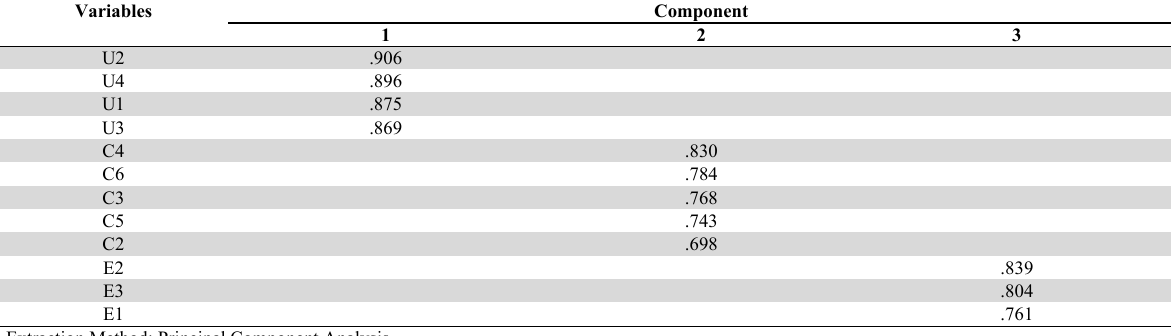
Extraction Method: Principal Component